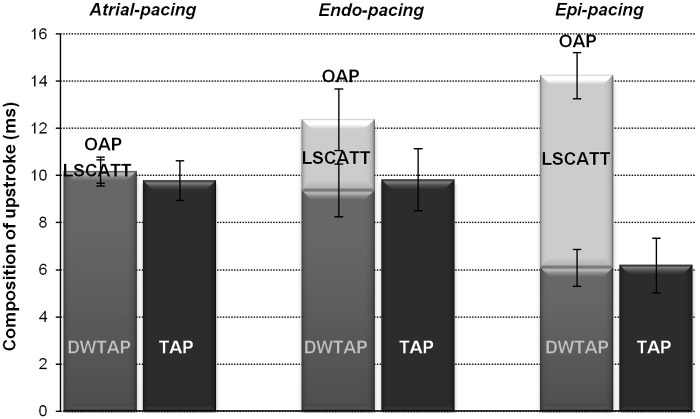
Mean data for the components composing the OAP upstroke.Bars represent the durations (means ± SEMs) for all components that contribute to the OAP upstroke: a transmural AP recorded with a microelectrode versus a full OAP (the sum of the depth-weighted TAP and the lateral-scattering component) obtained with the di-4-ANBDQBS dye, when stimulated in the atrium/endocardium/epicardium. The dark gray bar indicates the TAP, and the gray and light gray bars indicate the DWTAP and LSCATT components, respectively. The durations of the upstroke for TAP, DWTAP, and OAP were calculated using the time points that corresponded to 10 and 90% of the amplitude. LSCATT was calculated as the difference between OAP and DWTAP. Note that LSCATT was significantly different (P <0.05, n = 8 for each) for the various types of pacing.